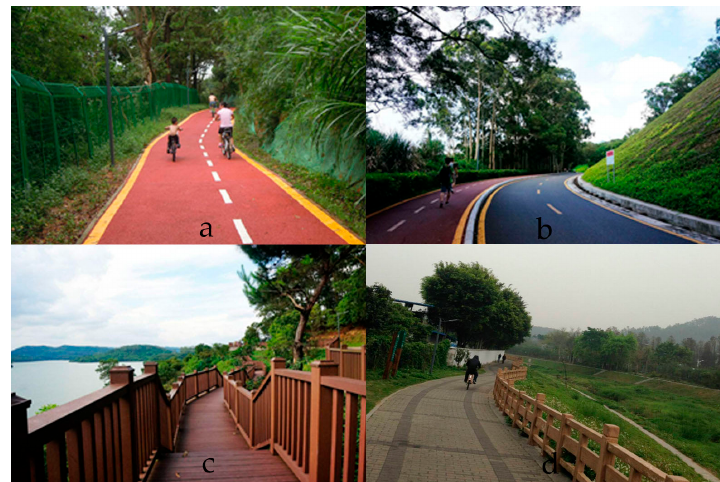
Figure 2. Photographs showing Wutong greenway: ( a ) greenway crossing the forest; ( b ) greenway along the road; ( c ) greenway besides the Shenzhen reservoir; ( d ) greenway along the Wutong river.